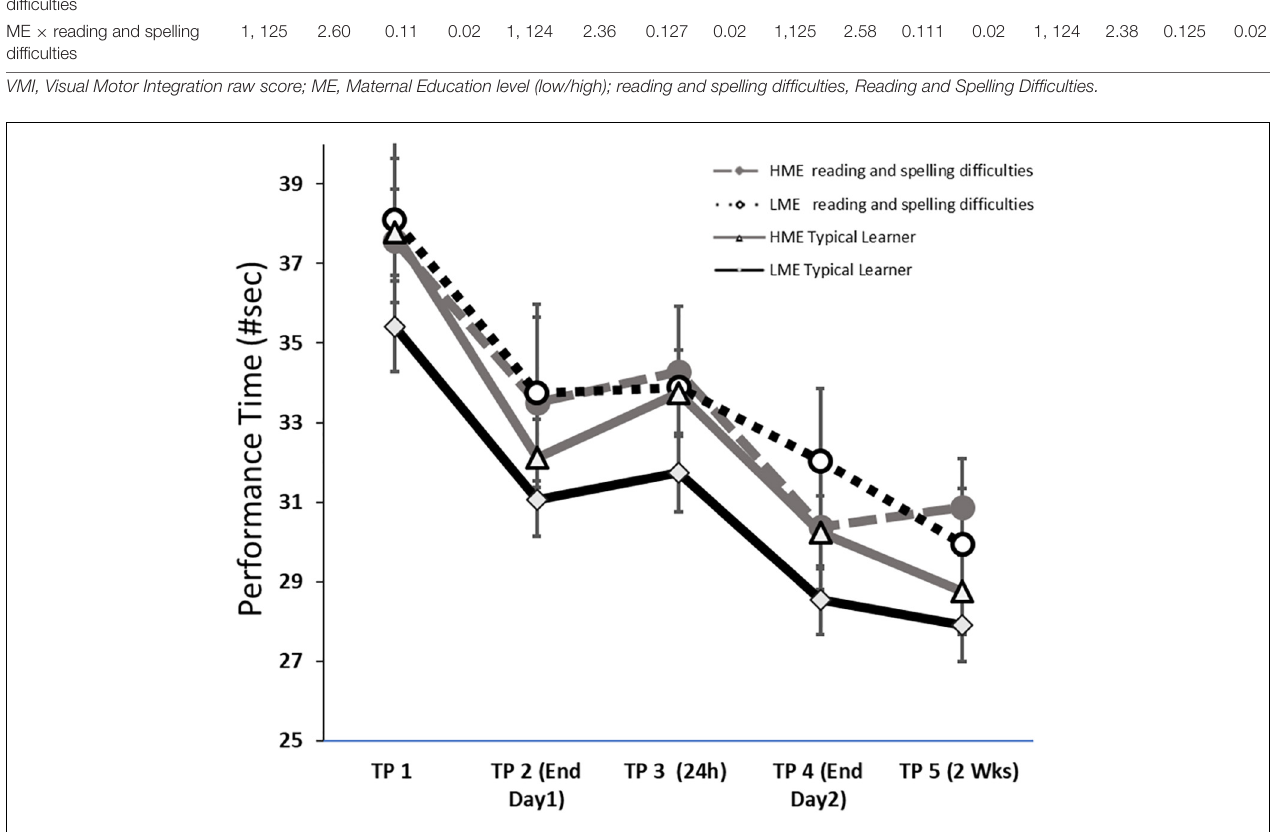
FIGURE 4 | ILT Performance times (#sec, mean and standard deviation) in the four groups: HME typical learner , typical learner with high maternal education; HME typical learner , typical learner with high maternal education; LME typical learner, typical learner with low maternal education; HME reading and spelling difficulties , reading and spelling difficulties with high maternal education; LME reading and spelling difficulties , reading and spelling difficulties with low maternal education. The figure depicts the five points in time: TPI (Init Day 1 ) Initial Day 1: TP2 (End Day 1) end of Day 1, TP3 (24 h) post-training initial of Day 2, TP4 (End Day 2) end of Day 2; TP5 (2 Weeks) and 2 weeks post-training retention